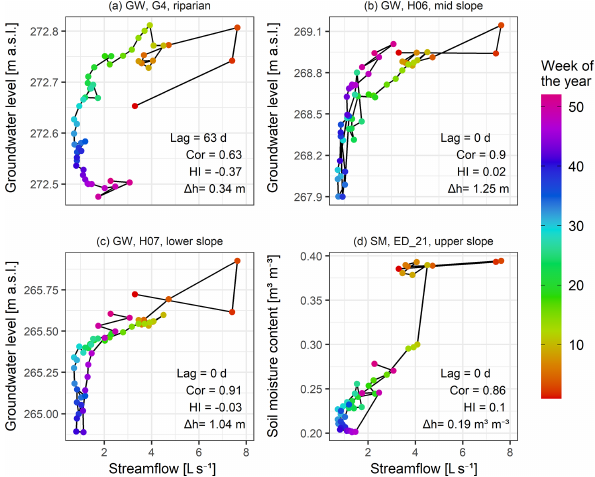
Figure 12. Seasonal hysteresis loops of three groundwater sta- tions (a–c) and one soil moisture station (d) to the streamflow for the year 2018 (Fig. 4). Circles’ colour represents the week of the year. Seasonal dynamics of each station in relation to the streamflow is described by seasonal shift (Lag), Spearman correlation (Cor), hys- teresis index (HI) and groundwater table elevation or soil moisture content change over the year ( (cid:49)h ).